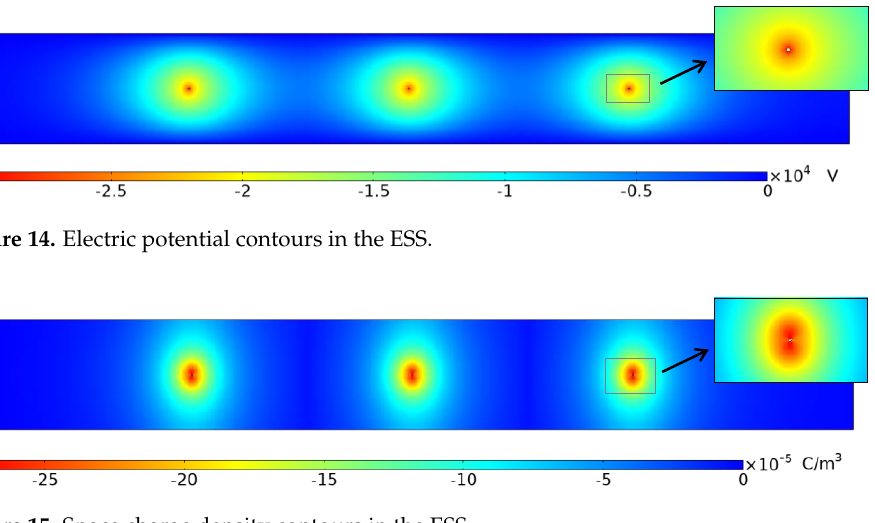
Figure 13. Velocity magnitude of the airflow inside the electrostatic sanitizer (ESS).